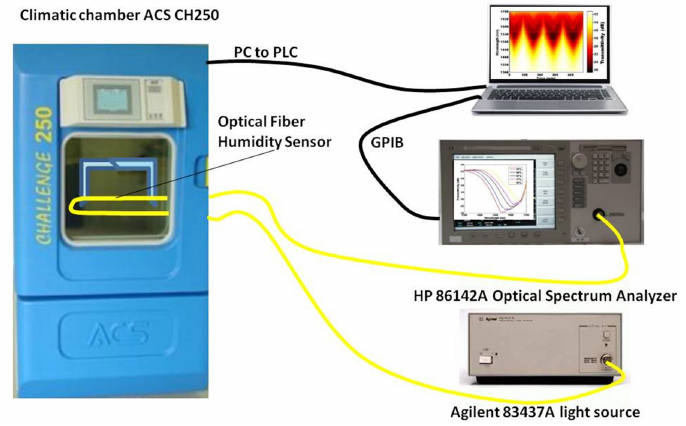
Fig. 2.- Refractive index of sputtered tin dioxide